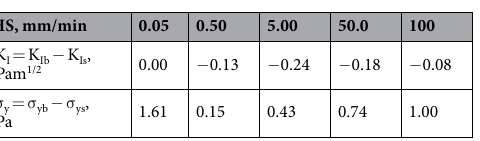
Table 1. Δ K I and Δσ y values for blunt and sharp notched HDPE at various crosshead speeds.